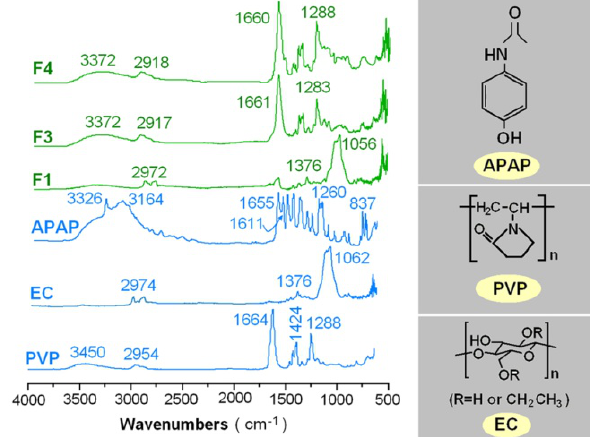
Figure 5. Compatibility investigation: ATR-FTIR spectra of the components (APAP, EC and PVP) and their electrospun nanofibers F1 (prepared by single fluid electrospinning) and F3, F4 (prepared by coaxial electrospinning) and the molecular structures of PAP, EC and